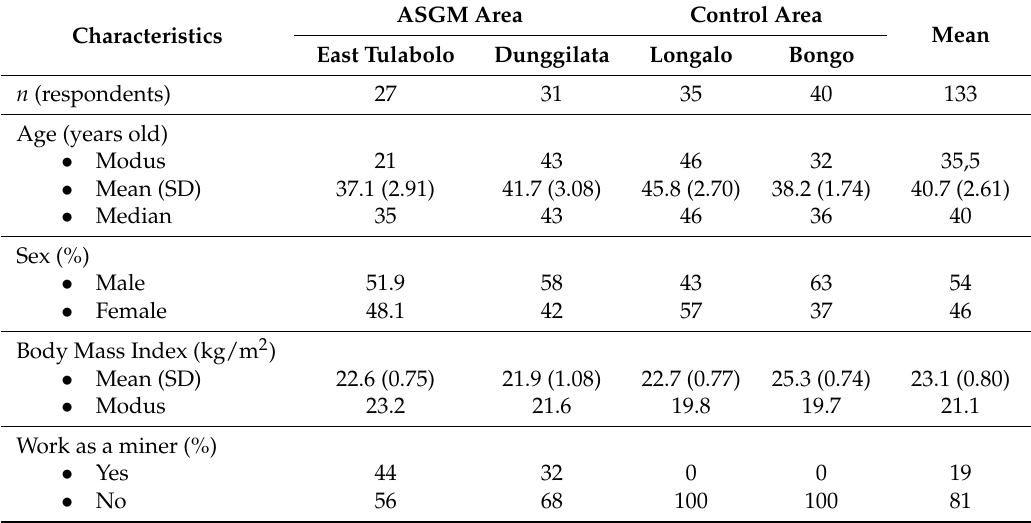
Table 1. Characteristics of respondents by artisanal and small-scale gold mining (ASGM) and control areas.